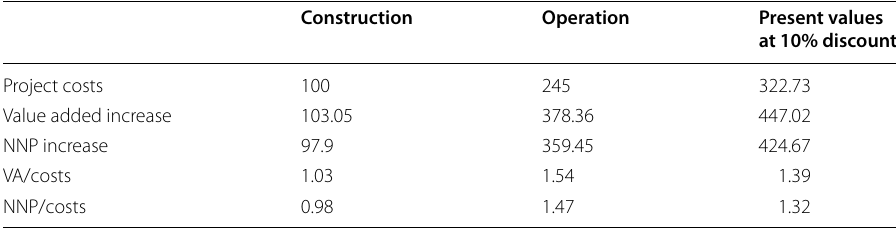
Table 6 Project performance